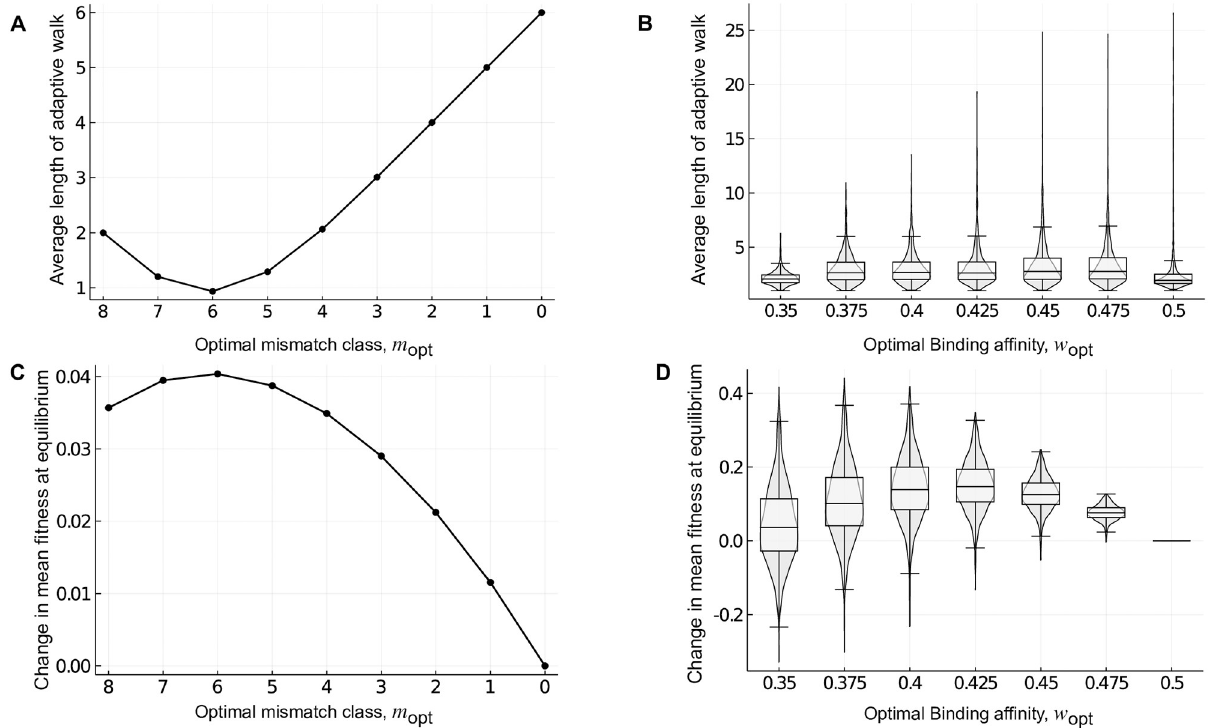
Fig 7. Rugged fitness landscapes need not impede adaptation. The average length of an adaptive walk h l i and the change in mean population fitness at equilibrium h f i is shown for landscapes of transcription factor-DNA interactions generated using (A,C) the mismatch model for e = 0.05 and (B,D) protein binding microarray data. In (B,D), violin plots show the distribution, and box-and-whisker plots the 25–75% quartiles, across the 1,137 empirical landscapes for each optimal binding affinity w opt . The large variability of h l i at intermediate and high w opt is a consequence of the random diffusion of the population on non-peak plateaus, which results in longer walks. In (C), μ = 0.1, σ = 1 while in (D) μ = 0.1, σ = 0.15.